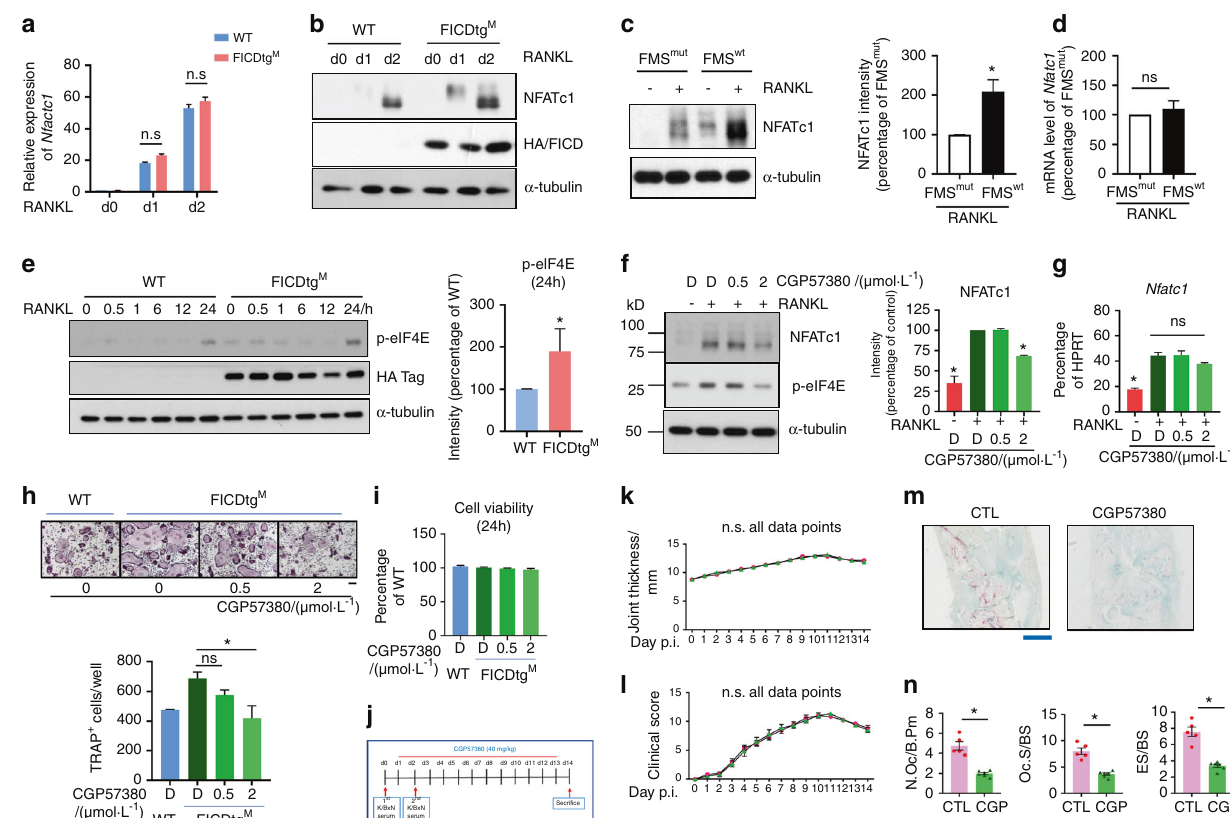
Fig. 6 The FICD augments NFATc1 expression by activating the MNK1/2/eIF4E axis. a , b BMDMs from WT and FICDtg M mice were stimulated with RANKL (50 ng·mL − 1) for the indicated times. a RT-qPCR analysis of Nfatc1 mRNA normalized to Hprt mRNA. b Immunoblot analysis with anti NFATc1, HA, or α -tubulin antibodies. c , d BMDMs from c-FMS f/ + Mx1-Cre mice were transduced with lentiviral particles encoding FMS wt or FMS mut and then cultured with M-CSF and RANKL. c Immunoblot analysis of whole cell lysate with anti-NFATc1 antibody. α -Tubulin was used as a control. The left panel shows representative images. The right panel shows the cumulative intensity of NFATc1 bands. The intensity of NFATc1 in FMS mut was set as 100%. d The mRNA expression level of NFATc1. e Immunoblot analysis of whole cell lysates with phospho-eIF4E antibodies. HA-tagged FICD was detected by HA-antibodies. α -Tubulin was used as a control. The left panel shows representative images. The right panel shows the cumulative percentage of the intensity of the band (at 24 h) relative to the control from three independent experiments. f , g BMDMs from WT mice were treated with CPG57380 at the indicated doses and then cultured with RANKL for 1 day. D: DMSO. f Immunoblot analysis with anti-NFATc1, phospho-eIF4E, or α -tubulin antibodies. The left panel shows representative images. The right panel shows the cumulative percentage of the intensity of the band relative to the control (RANKL + DMSO) ( n = 4). g Nfatc1 mRNA expression was measured by qPCR relative to Hprt mRNA. the DMSO-treated RANKL condition was set as 100%. h Osteoclastogenesis assay. BMDMs from WT and FICDtg M mice were treated with CPG57380 at the indicated doses and then cultured with RANKL for an additional 3 days. The upper panel shows representative images of TRAP-stained cells. The bottom panel shows the percentages of TRAP-positive multinuclear cells (MNCs: more than three nuclei) per control from three independent experiments. Scale bar: 100 μ m. i Cell viability assay. BMDMs from WT and FICDtg M mice were stimulated with CPG57380 at the indicated doses for 1 day. j – n K/BxN serum transfer-induced arthritis model. Nine-week- old male C57BL/6 J mice received K/BxN serum on days 0 and 2. Vehicle or CPG57380 (40 mg·kg − 1 , CPG) was administered intraperitoneally (i. p.) from day 2 until day 13. j Schematic diagram showing the experimental design. k Ankle thickness. l Arthritis score. m Representative images of TRAP-stained histological sections from the calcaneocuboid and tarsometatarsal joints. Scale bar: 1 mm. n Histomorphometric analysis of tarsal bones. N.OC/B.Pm Osteoclast number/bone parameter. OC.S/BS osteoclast surface/bone surface. ES/BS Eroded surface/bone surface. All data are shown as the mean ± SEM. CTL, Control. * P < 0.05; n.s. not signi fi cant by one-way ANOVA with a post hoc Tukey test ( a , f – i , k , l ) or two-tailed, unpaired t -test ( c , d , e , n ). The data represent at least three these proteins in both human and murine osteoclasts using enriched in protein synthesis and posttranscriptional modi fi ca- siRNAs. Both DAP5 and Fxr1 were increased upon RANKL tions (Fig. 7a). Among them, we focused on DAP5, which binds to stimulation, and knockdown of DAP5 and Fxr1 suppressed their MNK1 and is a part of protein translation initiation complexes 35 expression in both human and murine macrophages (Supple- (Fig. 7b, c). To verify the interaction between the FICD and DAP5, mentary Fig. 10g – j). Strikingly, DAP5 or Fxr1 de fi ciency suppressed we performed immunoprecipitation analysis using BMDMs from RANKL-induced eIF4E phosphorylation and NFATc1 protein wild-type and FICDtg M mice. We found that the FICD bound to expression (Fig. 7e – h), suggesting that the FICD/DAP5/Fxr1 axis DAP5 (Fig. 7d). As Fxr1 was shown to form a complex with DAP5 36 , plays an important role in eIF4E phosphorylation and NFATc1 we also examined whether Fxr1 interacted with the FICD. The FICD expression in osteoclasts. Accordingly, osteoclast differentiation also bound to Fxr1 (Fig. 7d), suggesting that the FICD might was also suppressed by DAP5 or Fxr1 de fi ciency (Fig. 7i, j). Our interact with the DAP5/Fxr1 complex. data suggest that the DAP5/Fxr1 complex contributes to the As the function of the DAP5/Fxr1 complex in osteoclasts has not activation of MNK1/2/eIF4E and NFATc1 expression in osteoclasts been previously characterized, we examined the effect of the and serves as a positive regulator of osteoclast differentiation. DAP5/Fxr1 complex on osteoclastogenesis by knocking down